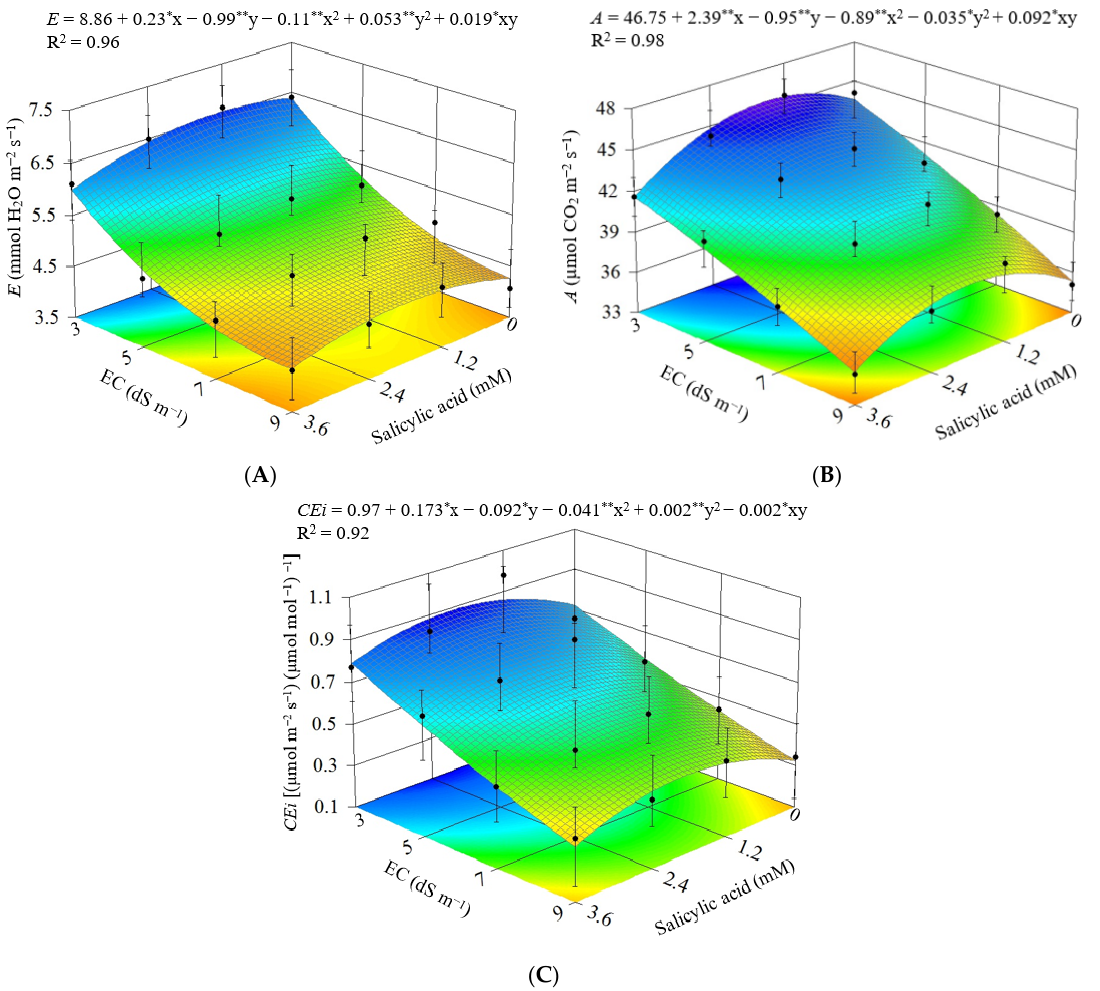
Figure 12. Response surface for transpiration— E ( A ), CO 2 assimilation rate— A ( B ), and instantaneous carboxylation efficiency— CEi ( C ) of ‘Canindé’ okra cultivated in a hydroponic system as a function of the interaction between the electrical conductivity of the nutrient solution (EC) and the concentrations of salicylic acid 60 days after transplanting. X and Y—Concentration of salicylic acid and EC, respectively; * and ** significant at p ≤ 0.05 and ≤ 0.01, respectively. The vertical lines represent mean +/ − standard error (n = 4).